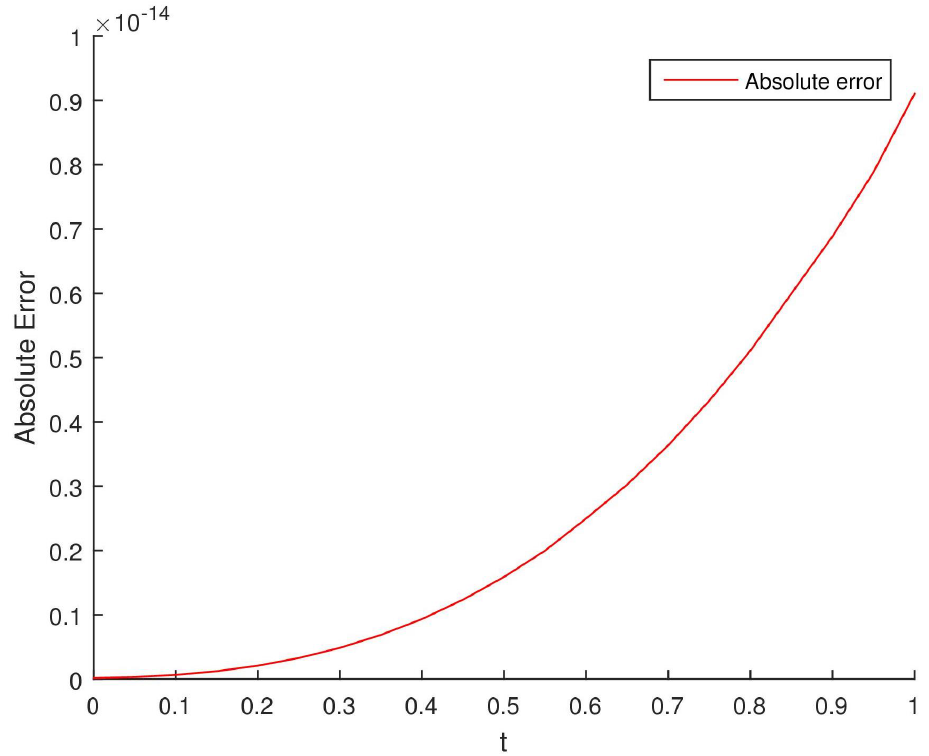
Figure 14. The demonstration of the absolute error for Example